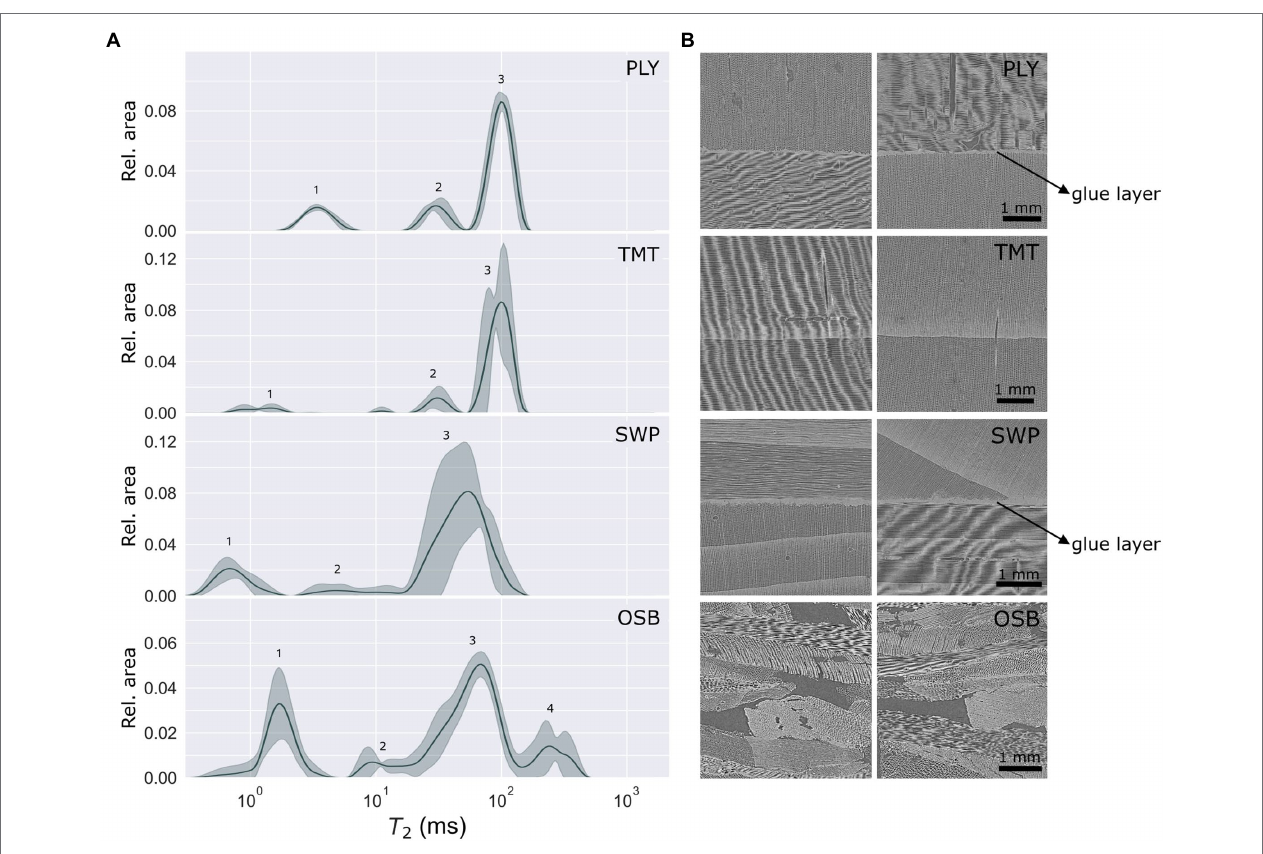
FIGURE 3 | (A) Continuous T 2 distributions (with peak numbers 1, 2, 3 and 4) of four wood-based panels, showing the mean value (line) and standard deviation (filled zone); (B) X-ray CT section of the wood-based panels, appr. 4 × 4 mm 2 , showing the center of the specimen seen from the front (left) and the side (right) for